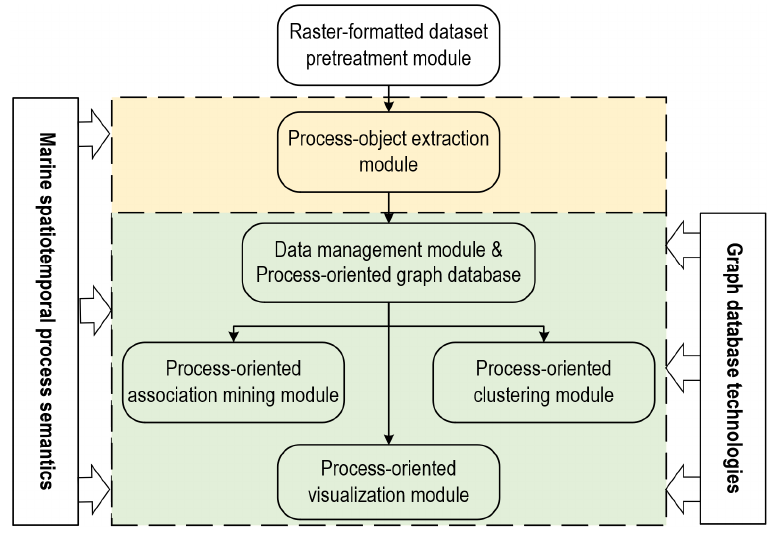
Figure 2. Modules and their logics.